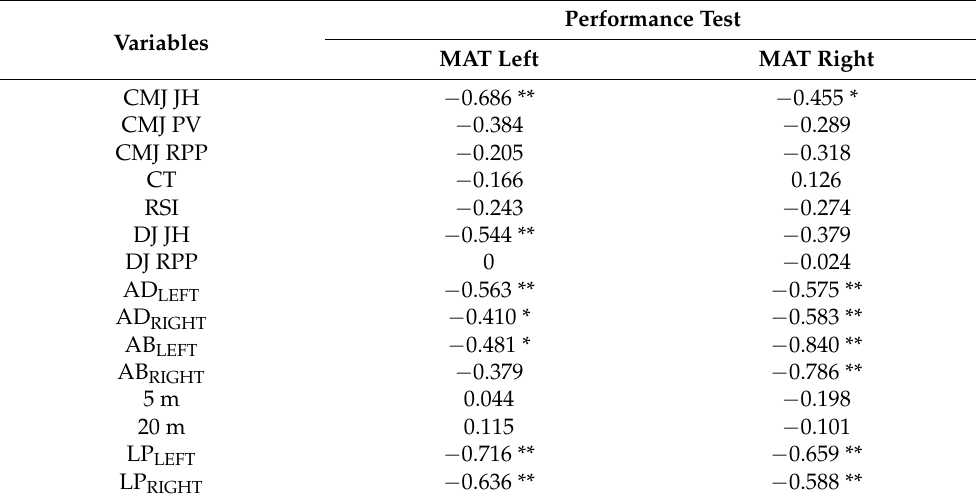
Table 2. Correlations between the MAT tests and vertical jump variables, 5 m and 20 m sprint time, abductors and adductors maximum isometric strength, and leg